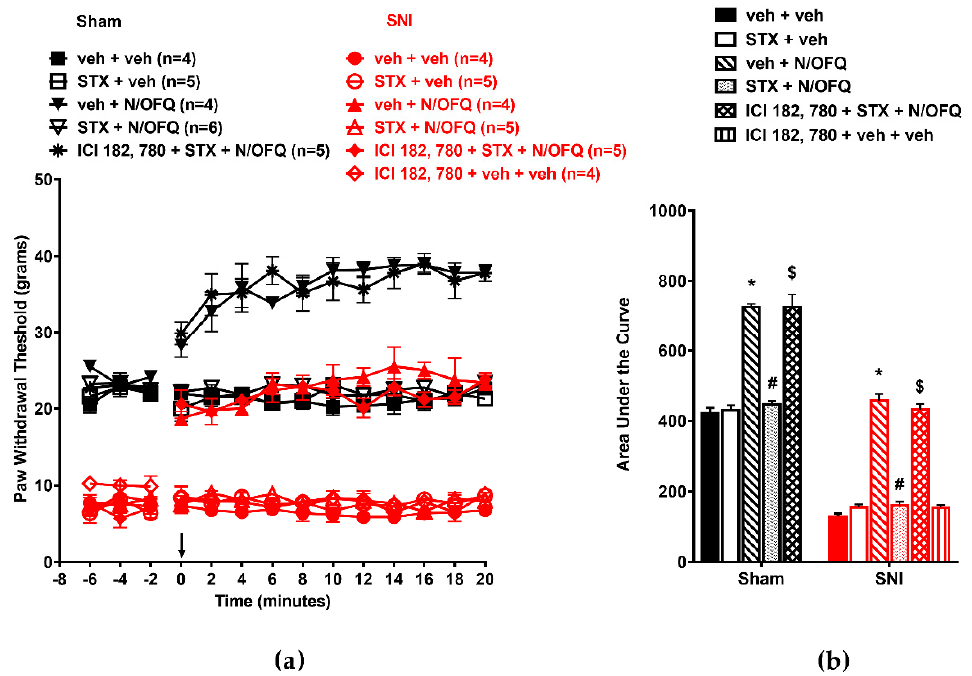
Figure 9. Selective activation of Gq-mER attenuated NOP-mediated antihypersensitivity in OVX rats: ( a ) SNI of the sciatic nerve significantly reduced PWTs compared to the sham group.